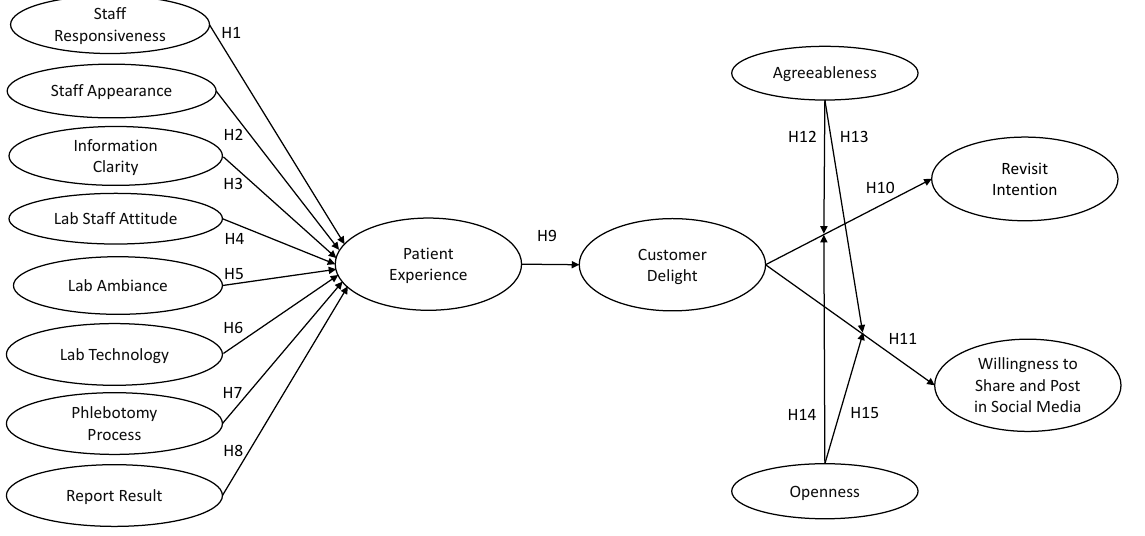
Figure 1. Conceptual